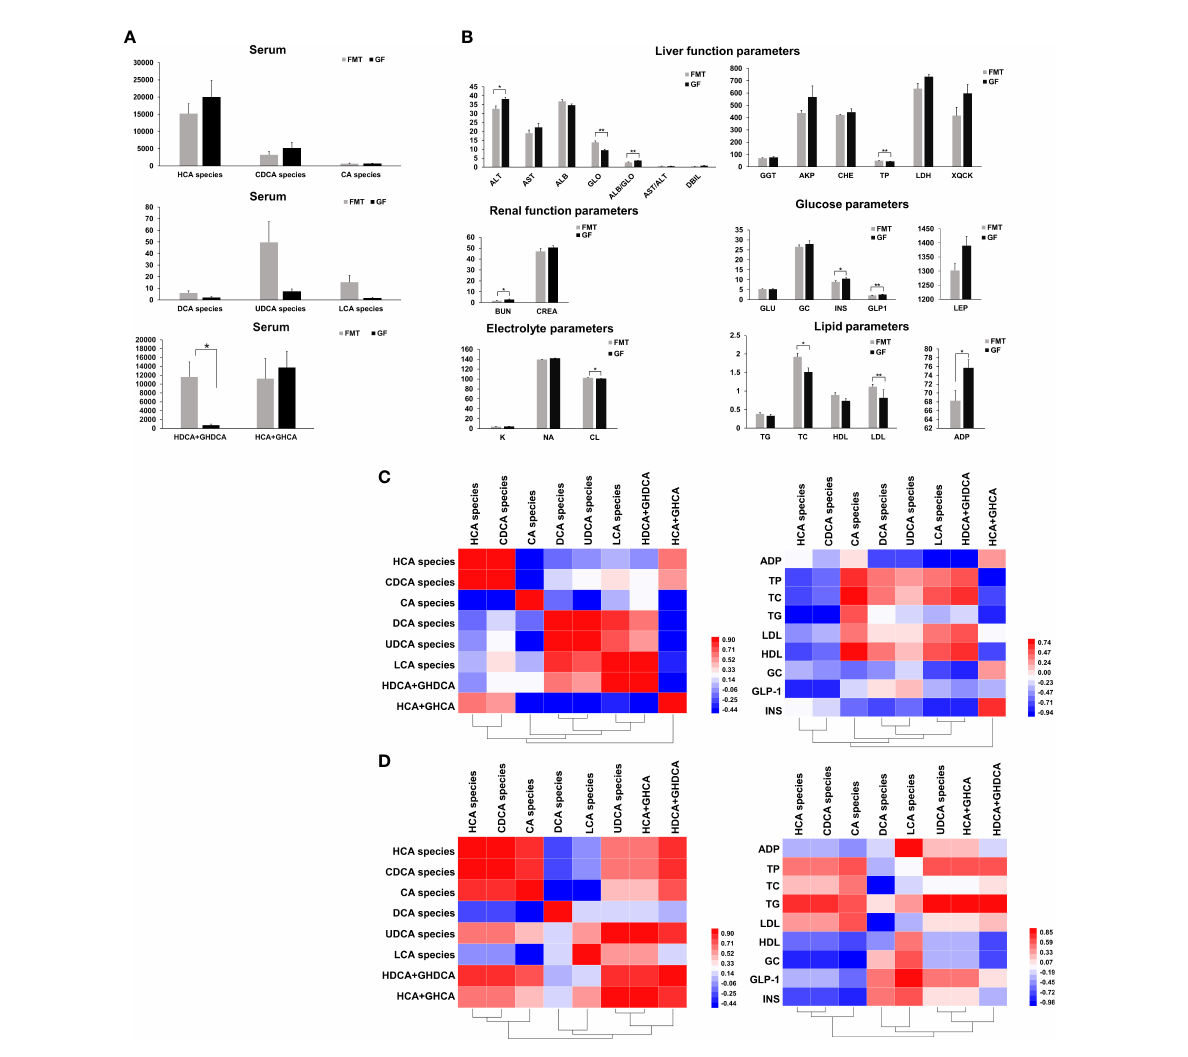
FIGURE 4 Bile acid species and blood biochemical parameters in the serum of FMT and GF piglets. (A) Changes in the concentrations of various bile acid species. (B) Changes in the levels of blood biochemical parameters after colonization of pig microbiota. Mean values ± SE are plotted; n = 5 samples in the GF group, n = 6 samples in the FMT group. * P < 0.05, ** P < 0.01 indicate differences versus GF by the Welch Two-Sample t -test. Spearman correlation coef fi cients for concentrations of HCA species and the blood biochemical parameters in the serum of FMT piglets (C) or GF piglets (D) . The value in the unit square represents the correlation coef fi cient. An asterisk * represents a signi fi cant correlation at the 0.05 level (two-tailed); ** represents a signi fi cant correlation at the 0.01 level